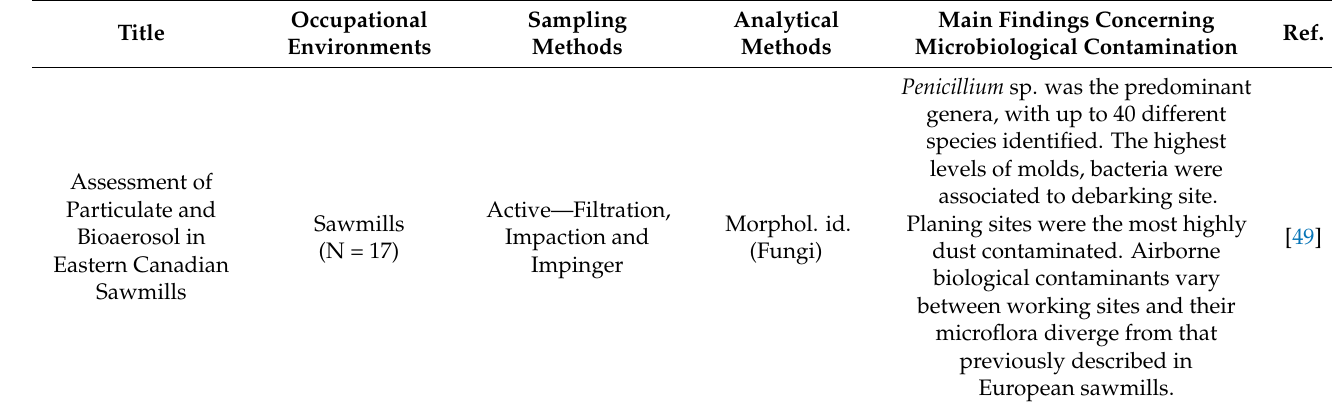
Figure 1. PRISMA based selection of articles. Table 2. Data selected from the chosen